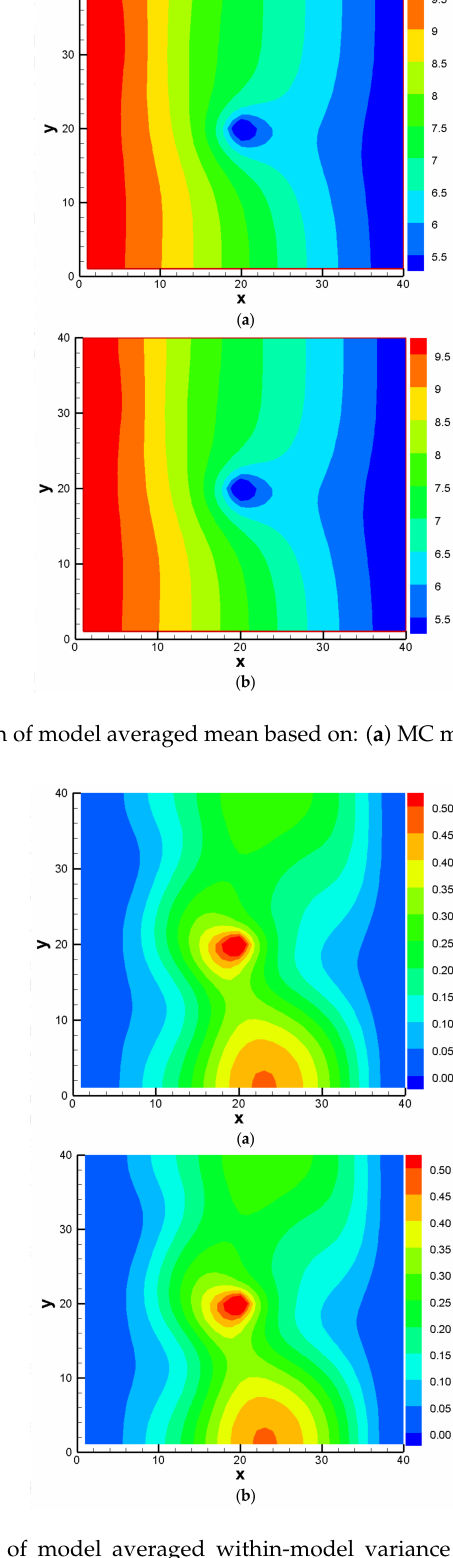
Figure 10. Comparison of model averaged within-model variance based on: ( a ) MC method; ( b ) PCM